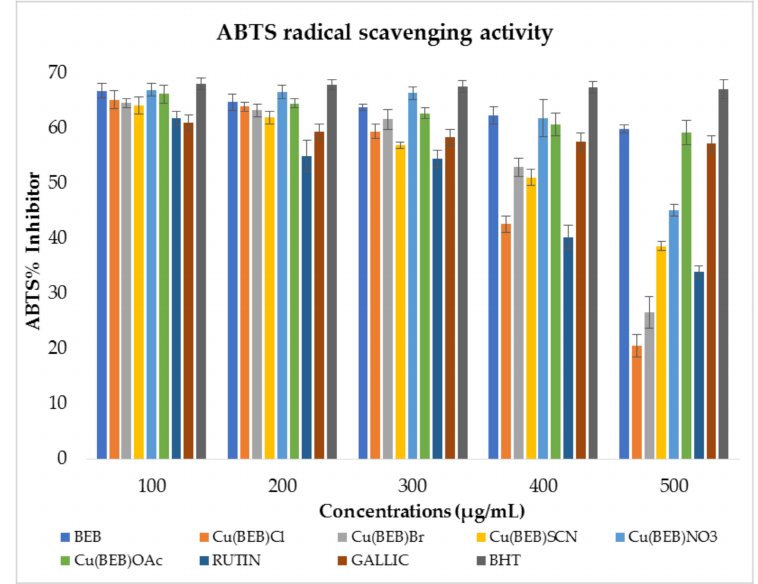
Figure 6. ABTS activities of BEB, its Cu(II) complexes and standard drugs (n = 3).